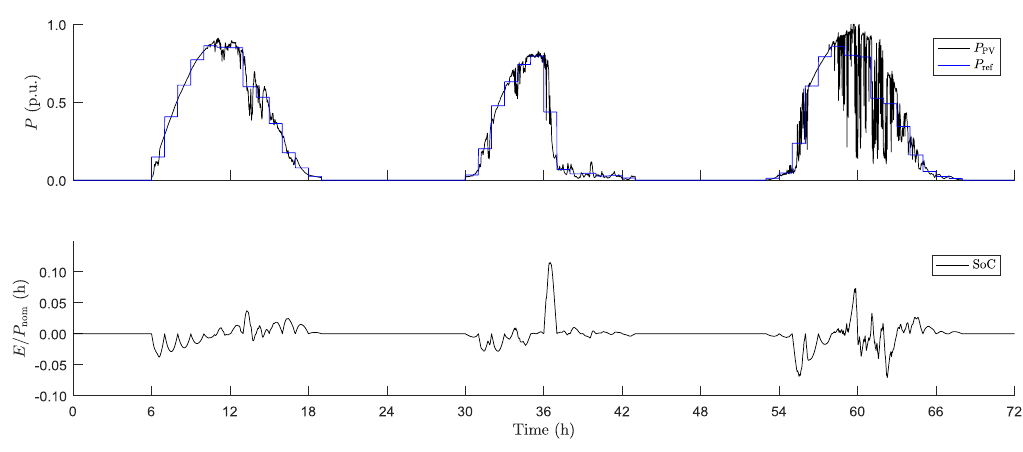
Figure 3. On top is the PV generator output power and the power fed to the grid, i.e., reference power for SoC for one hour ISP, and below is the state of charge of ESS during three days from 11 April to 13 April in 2015.